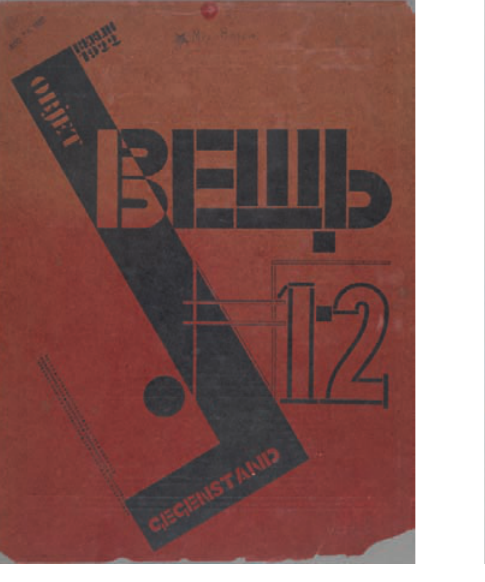
fig. 2 Copertina del secondo